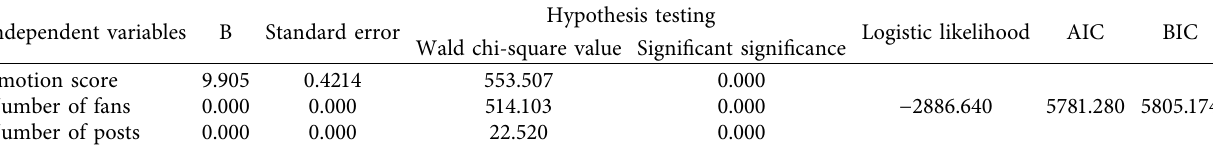
Table 6: Negative binomial regression parameter estimates (prosocial posts and number of forwarded posts).